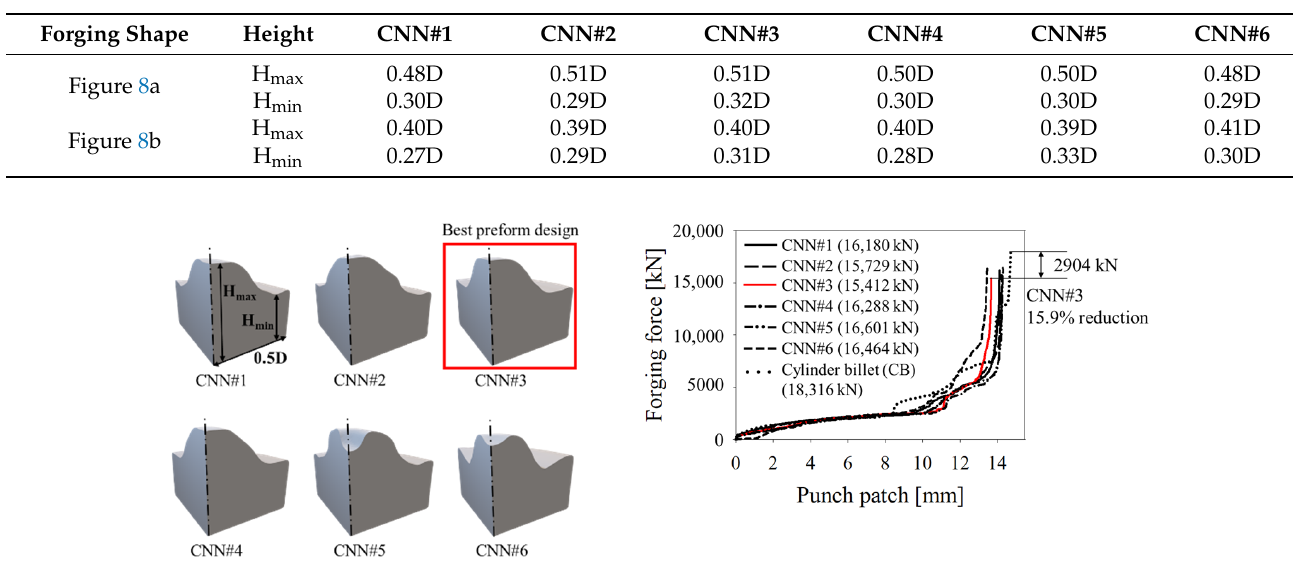
Figure 9. ( a ) Preform geometries and ( b ) forging force–punch patch curves computed for each of the CNN sub-models (including the cylindrical billet) for the forgings of Figure 8a.